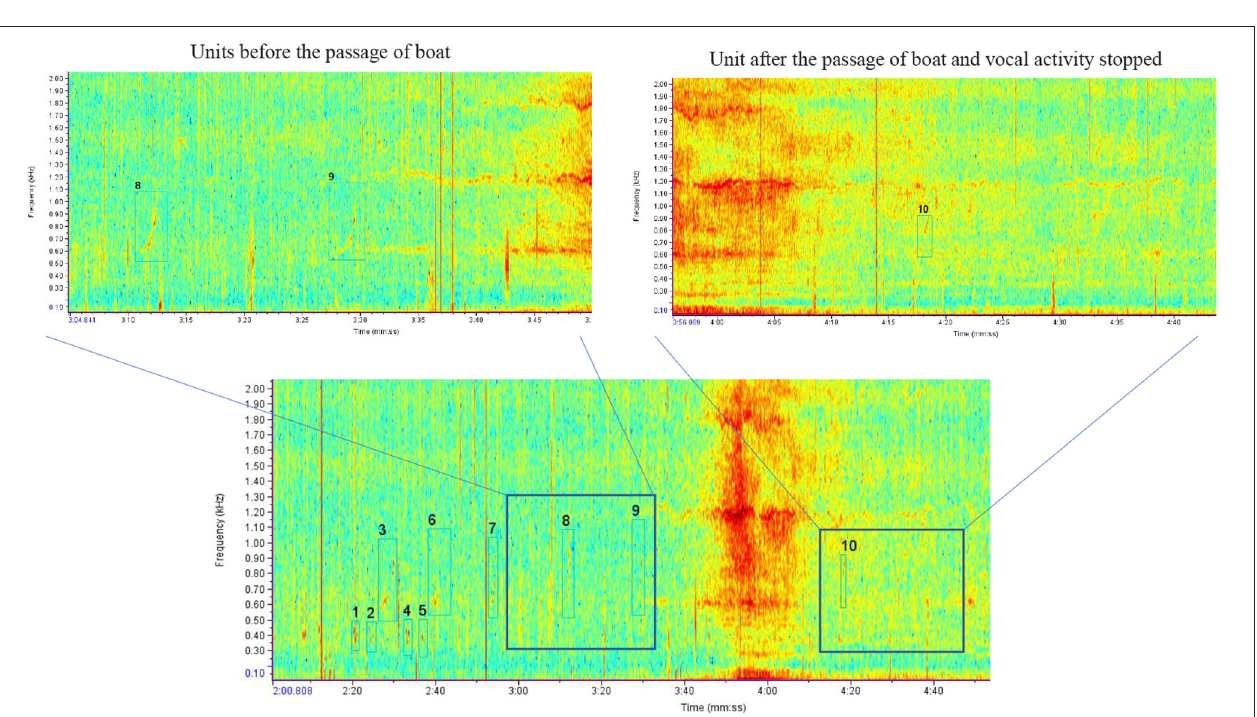
FIGURE 6 | Example of structural change in a song: stopped singing. At the beginning of the spectrogram, a phrase change happened to the song denoted by the 1, 2, and 3 (AAB) boxes (blue) until 3:40 when the boat pass began. During boat noise, units were difficult to identify. At 4:20 when the boat pass ended, the final unit able to be found (box 10) matched unit B of the phrase from before (boxes 3, 6, 7, 8, and 9). No more singing was heard/seen for the remainder of the 10-min recording (color online).